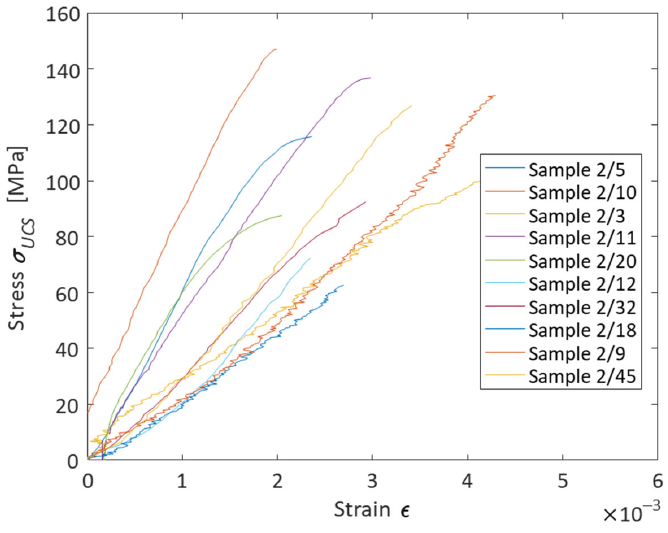
Figure 8. A loading diagram for ten cylindrical specimens of a geomaterial saturated with air or distilled water showing stress–strain coordinates. Table 1. Results of the uniaxial compression tests of limestone geomaterial samples. Data on air ‐ dried samples are in the top rows, and data on water ‐ wet samples are in the bottom rows.